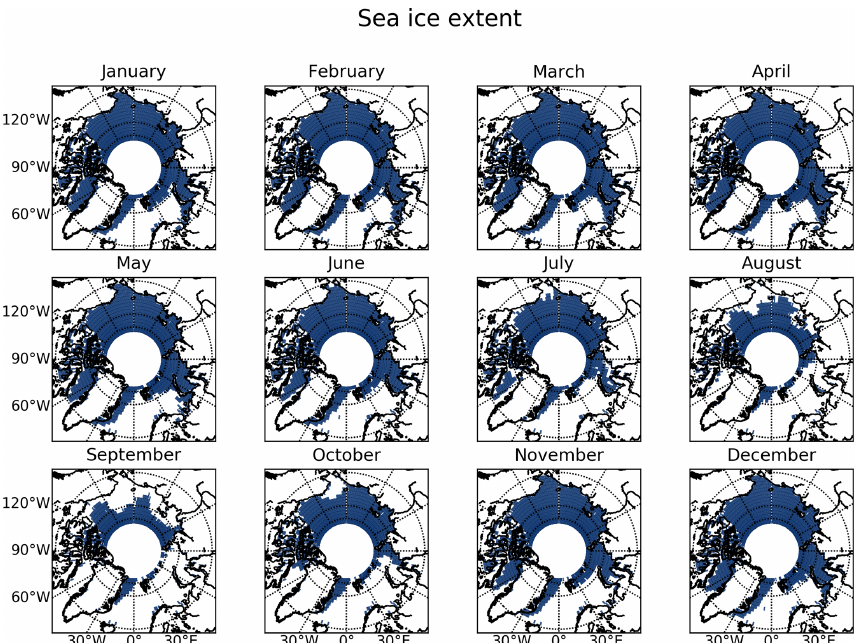
Figure A5. The monthly sea ice extent is defined from space-borne observations of AMSR-E/AMSR2 on a 6.25km grid (Spreen et al., 2008) for the studied